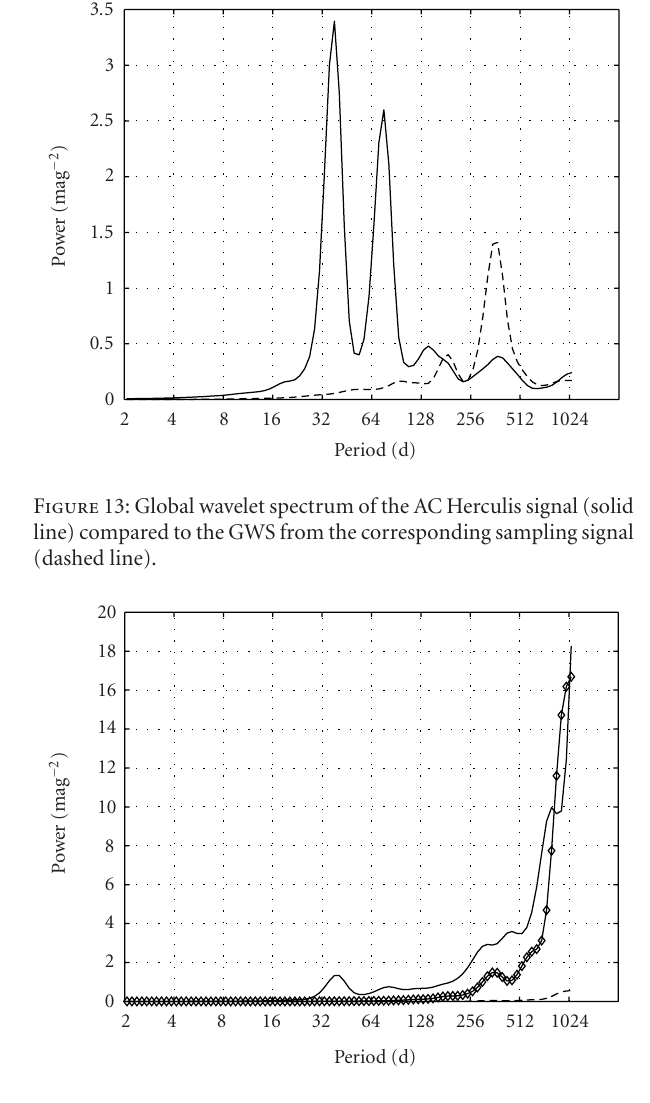
Figure 14: Global wavelet spectrum of the RV Tauri signal (solid line) compared to the GWS from the corresponding sampling signal (dashed line). The solid line with diamonds represents the dashed line multiplied by a factor 20, for